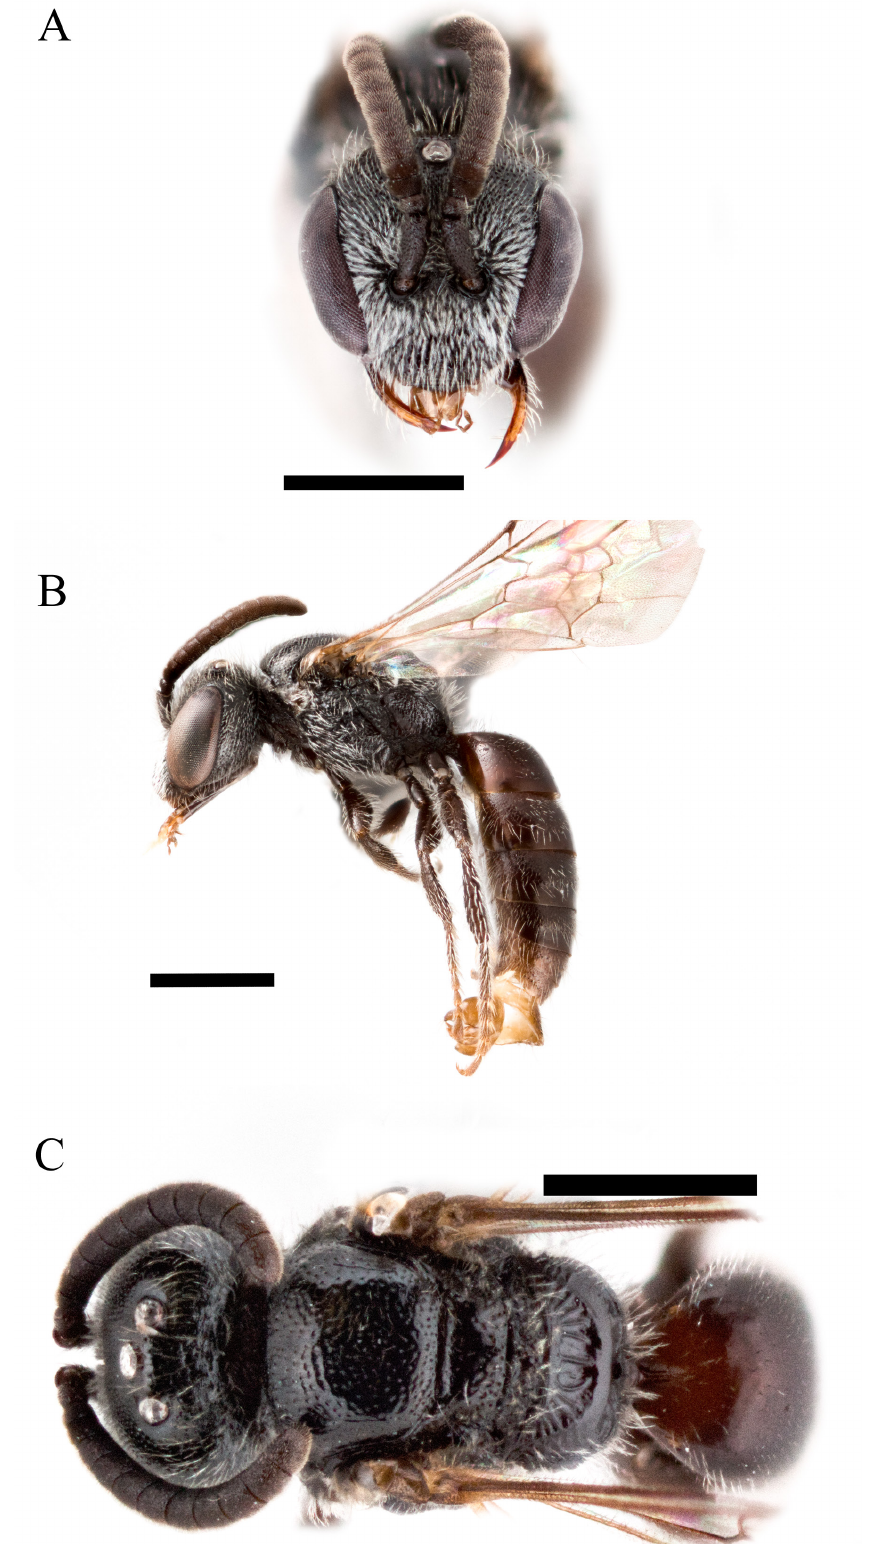
Fig. 11. Sphecodes albifacies sp. nov. Holotype (A) and paratype (B–C), ♂♂. A . Face. B . Lateral habitus. C . Dorsum of mesosoma. Scale bars = 1